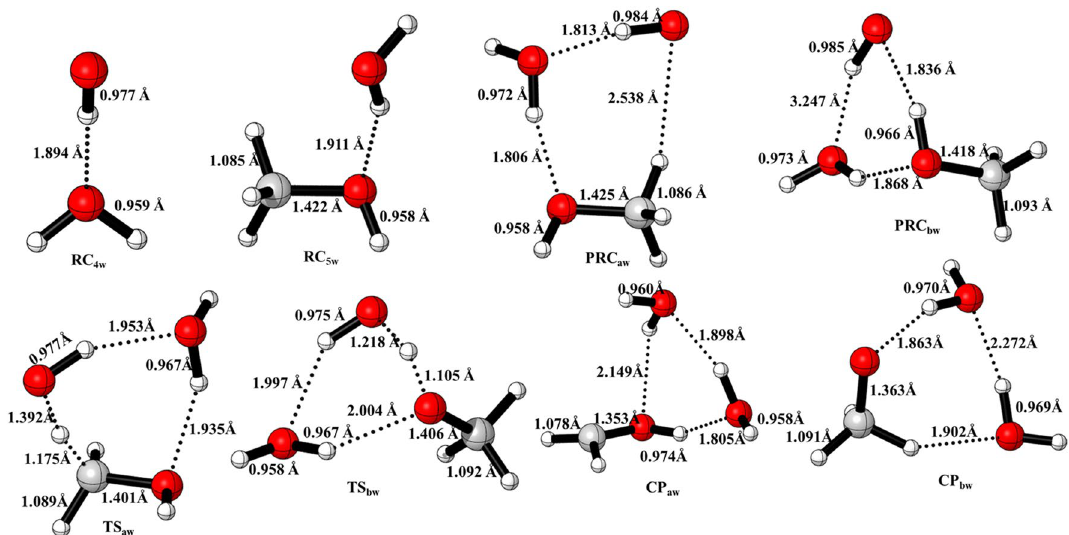
Figure 6. Structures of water-assisted pre-reactive complexes, transition states and post-reactive complexes were optimized using